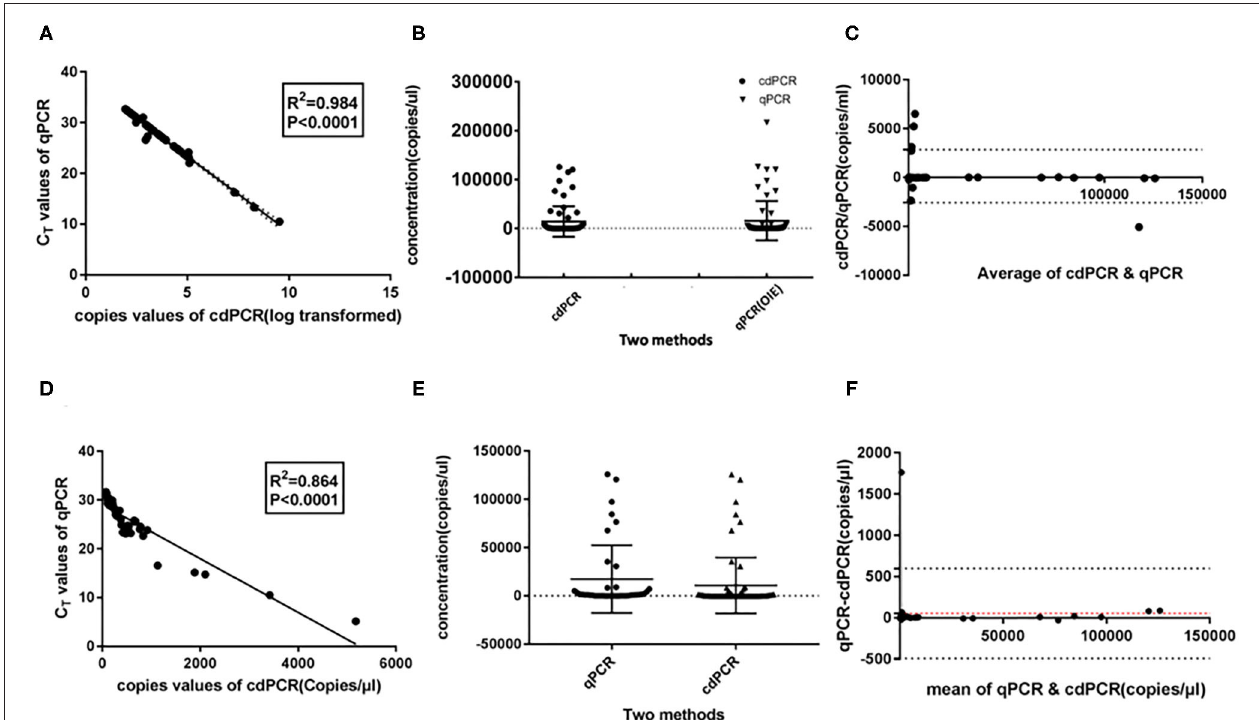
FIGURE 8 | Statistical analysis for cdPCR in testing clinical blood samples. Pearson correlation and linear regression analysis showed well-consistency between qPCR approved by OIE ( R 2 = 0.864) (A) as well as between cdPCR and commercial qPCR kit ( R 2 = 0.864) (D) . The standard deviation of cdPCR is lower than that of qPCR approved by OIE (B) and that of commercial qPCR kit (E) . (C) Bland and Altman analyses plots for cdPCR and qPCR approved by OIE demonstrated that 5.797% (4/69) dots were outside the region between 95% lower limit of agreement and 95% upper limit of agreement, and the bias value for this agreement’s range was 1,381 copies/ml ( P < 0.05) by Graphpad Prism 7.04. (F) Bland and Altman analyses plots for cdPCR and the kit demonstrated that 1.449% (1/69) dots were outside the region between 95% lower limit of agreement and 95% upper limit of agreement with that of the bias